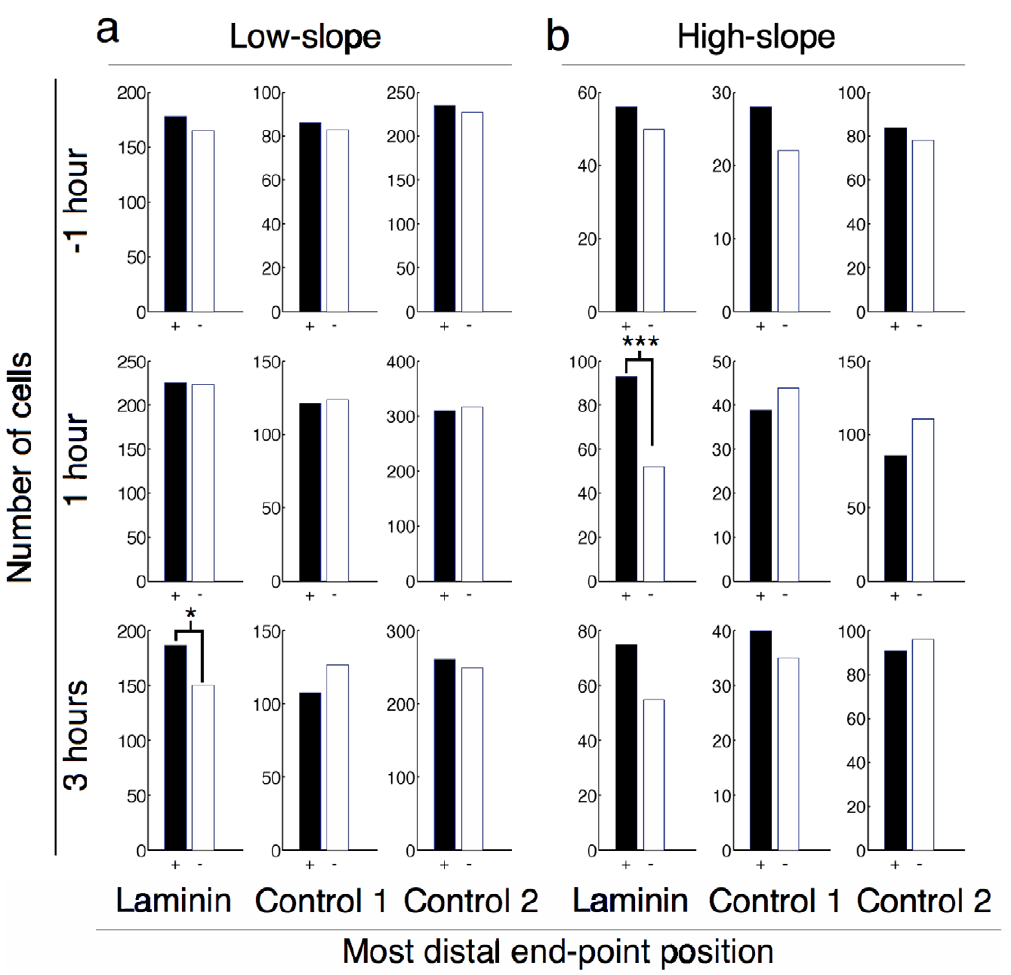
Figure 3. Neurite extension bias according to most distal end-point. Histograms of most distal end-point relative to soma centroid position for all cell images in both low-slope and high-slope gradients at time points before and during differentiation with staurosporine. Attracted (black, + ) and repulsed (white, 2 ) neurites were determined as described in Figure 2a. Low-slope gradients resulted in statistically significant guidance for laminin-1 three hours after differentiation (p=0.044 by x 2 ). High-slope gradients resulted in guidance that was statistically significant at 1 hour (p=0.0006 by x 2 ) after differentiation by staurosporine.